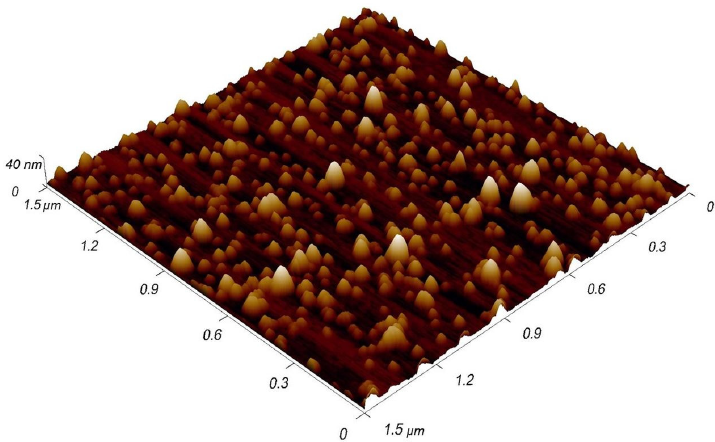
Figure 1. AFM image of size-filtered Cu NPs deposited on Si substrate.